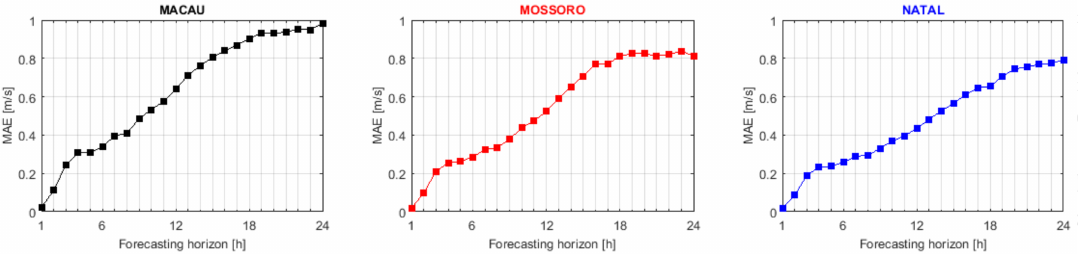
Figure 14. MAE of test sets for the best ESN. From left to right: Macau, Mossoro and